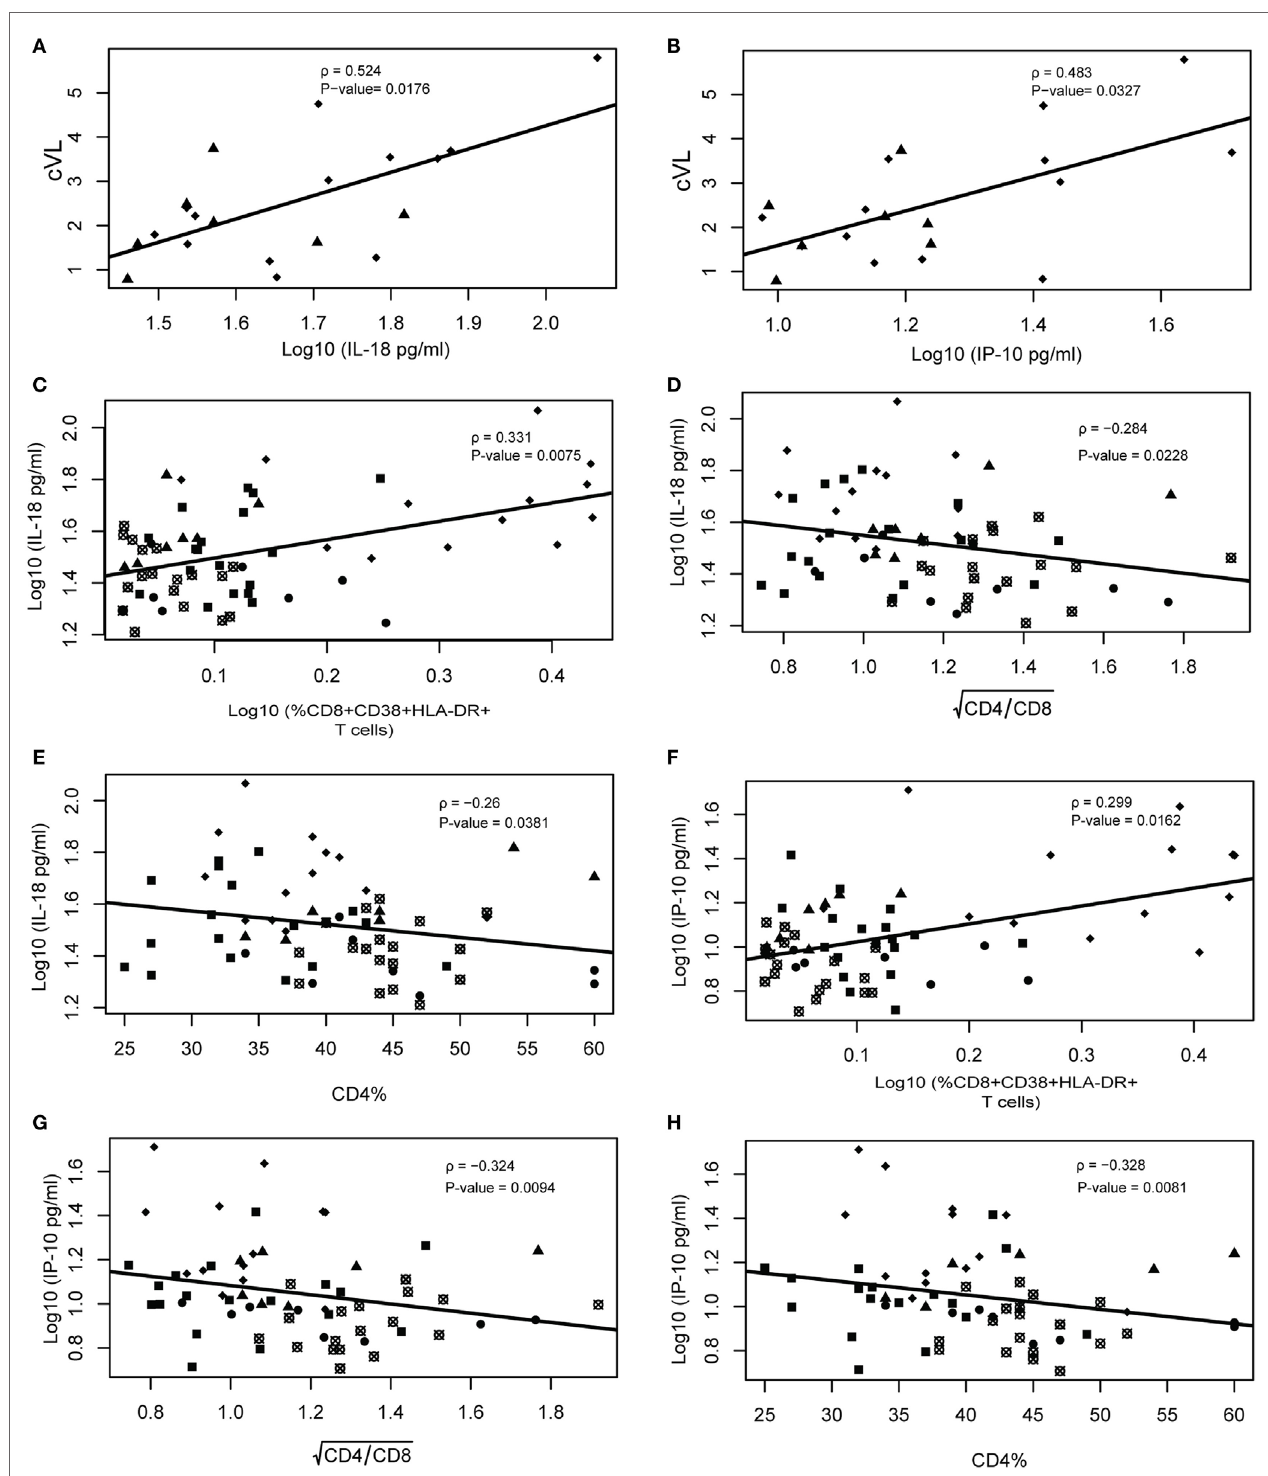
FigUre 4 | IL-18 and IP-10 correlate with cumulative viral load, CD4/CD8 ratio, and CD4%. Viral load correlations were performed only using ebbing elite controller (EEC) and viremic controller (VC) groups. Spearman rank correlation of IL-18 vs cumulative viral load (cVL) (a) and IP-10 vs cVL/year (B) . Correlation between IL-18 vs %CD8 + CD38 + HLA + DR + (c) , CD CD4 8/ (D) , and %CD4 (e) ; and between IP-10 vs %CD8 + CD38 + HLA + DR + (F) , CD CD4 8/ (g) , and %CD4 (h) . Spearman’s rank correlations coefficient analysis was performed among these variables with type I error adjustment for multiple comparisons following the Holm–Bonferroni method. Crossed open black circles, HIV-neg; solid black squares, combined antiretroviral therapy; solid circles, persistent elite controller; solid black triangles, EEC; and solid black lozenges,